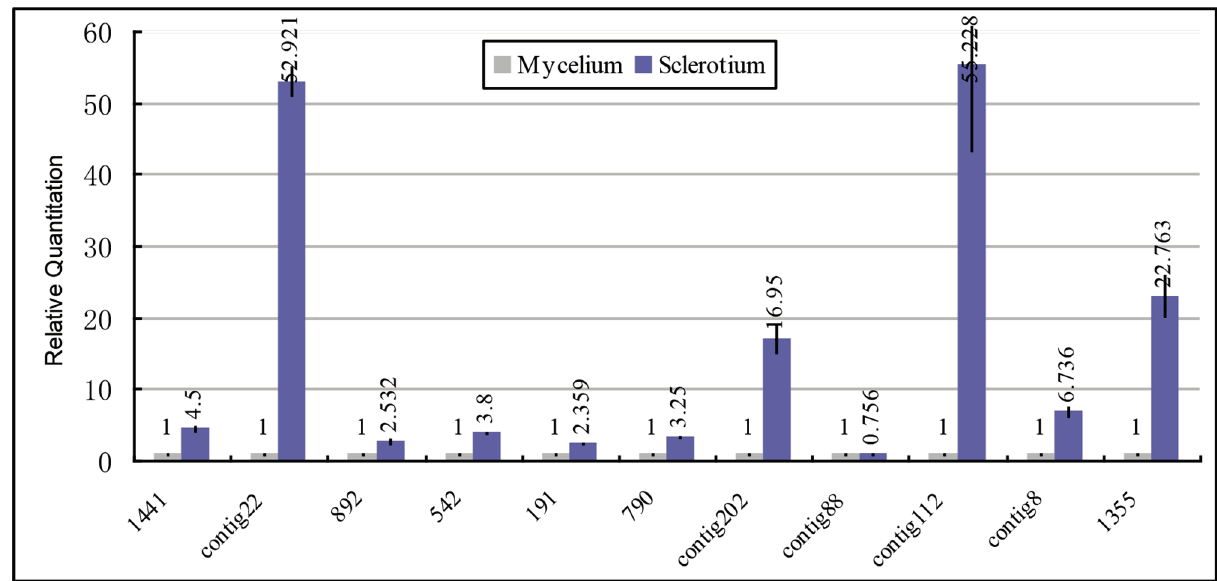
Figure 6. Expression patterns of growth related genes from SSH library using qPCR analysis. Blue columns represent the RQ in sclerotium; light grey columns indicate the RQ in mycelium. All standards were run in duplicate and samples were run in triplicate. Pu1441: cytochrome P450; Puctg22, Puctg8: hemolysin; Pu892, Pu542: inhibitor of apoptosis; Pu191: Cyclins, Pu790: cyclophilin, Puctg202, Puctg112: hydrophobin; Pu1355: C-4 sterol methyl oxidase; Puctg88: